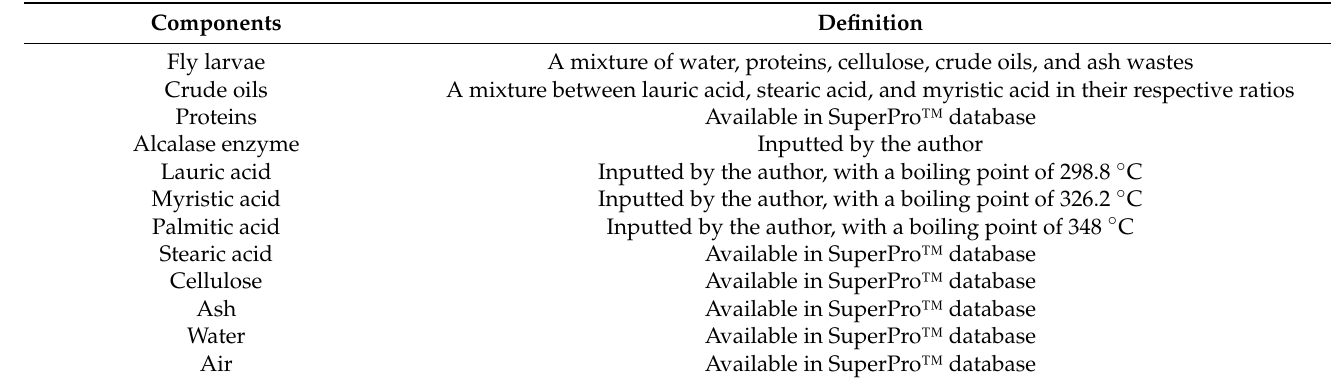
Table 1. The components of the simulation.